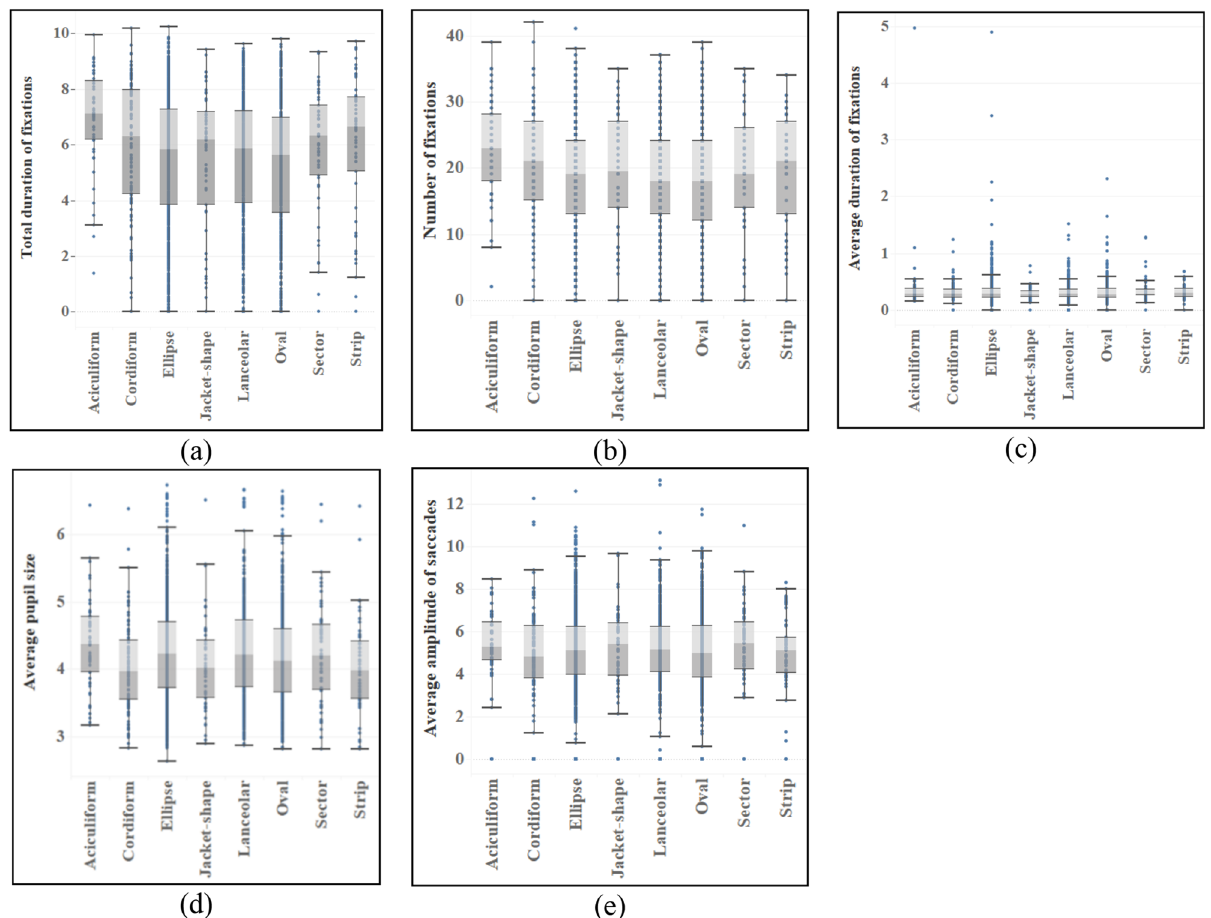
Figure 4. Eye movement index of different leaf shapes.